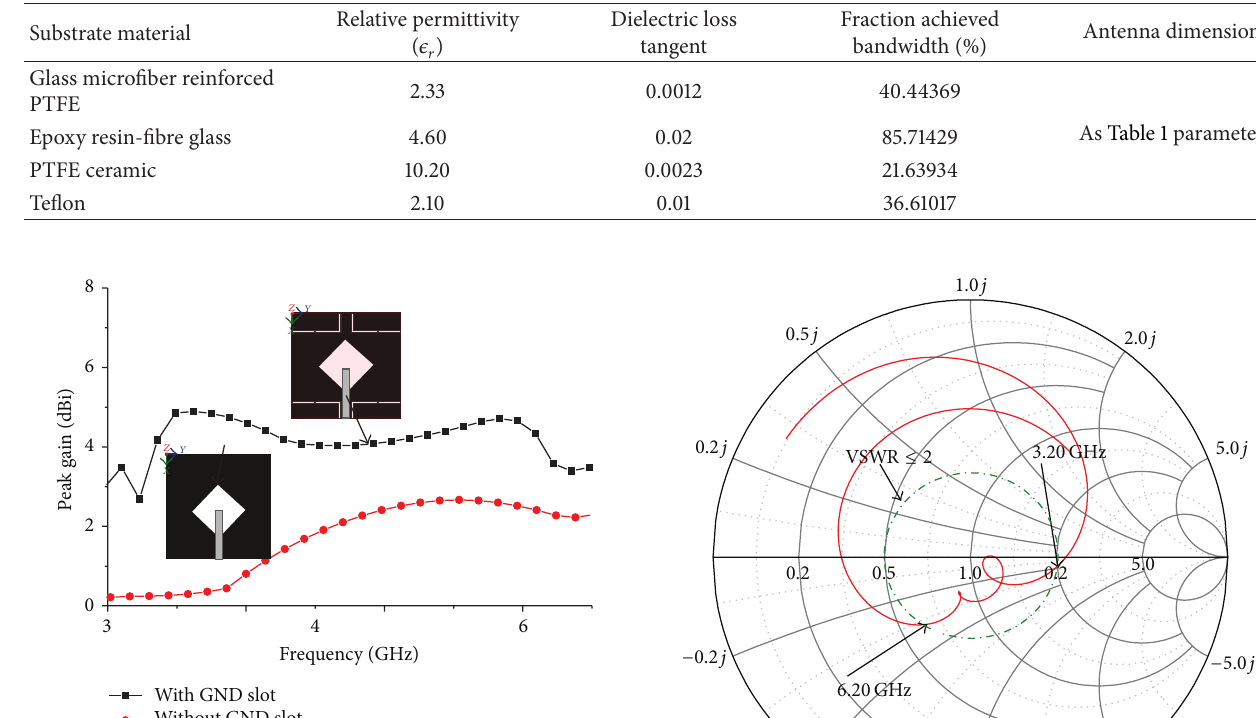
Table 2: Dielectric properties of substrate materials.